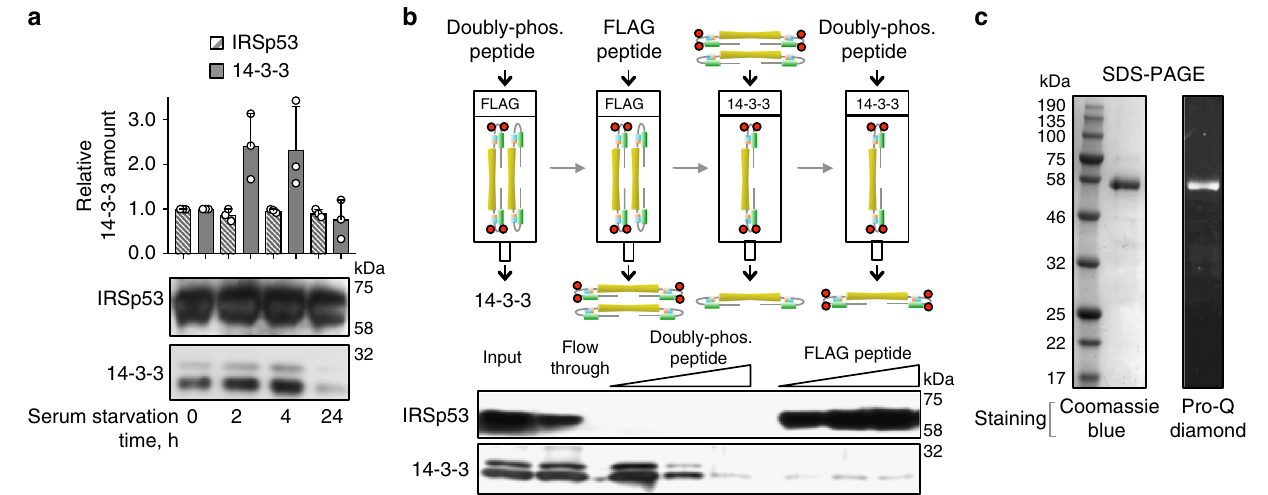
Fig. 1 Puri fi cation of natively phosphorylated and 14-3-3-binding-competent pIRSp53. a Effect of serum starvation on the relative amount of 14-3-3 (gray bars) that coimmunoprecipitates with IRSp53-FLAG (stripped bars) from HEK293T cells. Error bars are ± s.d. from three independent experiments, shown as open circles. Abundance is reported relative to the amount of expressed IRSp53-FLAG or endogenous 14-3-3 in fed cells ( fi rst column). Note that serum starvation does not affect the expression of IRSp53-FLAG, but increases the relative amount of 14-3-3 that coimmunoprecipitates with it. An optimal starvation time of 2 h was established from these experiments. b Puri fi cation of phosphorylated IRSp53-FLAG from HEK293T cells. Cells were serum- starved for 2 h to enhance IRSp53 phosphorylation. Endogenous 14-3-3 bound to IRSp53 is competitively removed by addition of the doubly- phosphorylated IRSp53 peptide Sites 2,3 (Supplementary Table 1). The 14-3-3-binding-competent fraction of IRSp53 is then isolated through consecutive af fi nity puri fi cation steps (FLAG-af fi nity and 14-3-3-af fi nity), eluting IRSp53-FLAG by competition with either FLAG or Sites 2,3 peptides. c Coomassie and Pro-Q Diamond-stained SDS-PAGE gels showing that the isolated fraction of IRSp53 is pure and